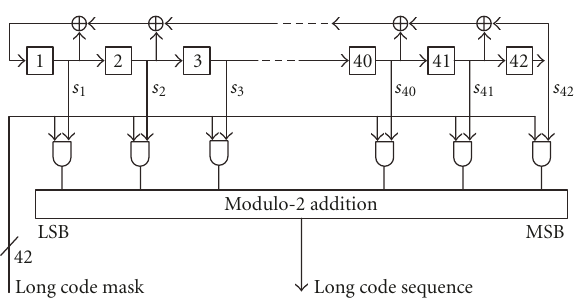
Figure 2: IS-95 long-code